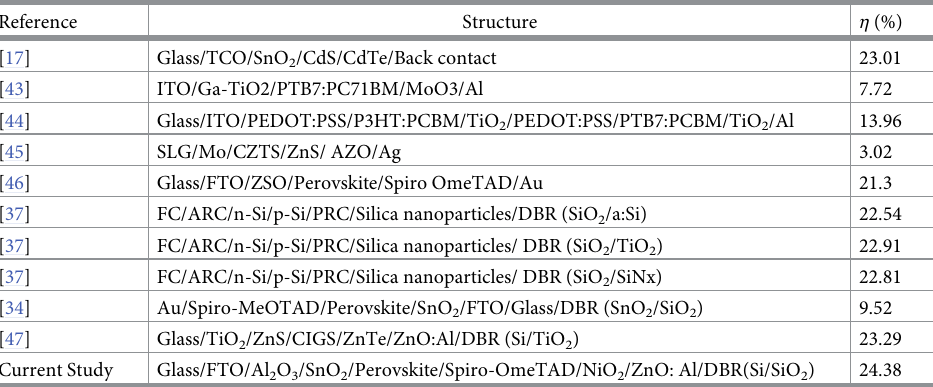
Table 2. Comparison of the current study with various kind of solar